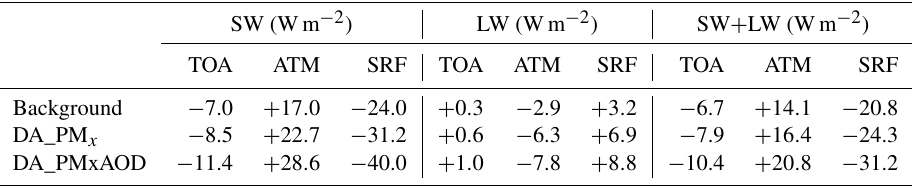
Table 5. The mean instantaneous clear-sky shortwave (SW), longwave (LW), and the net (SW + LW) direct radiative forcing (Wm − 2 ) at the top of the atmosphere (TOA), in the atmosphere (ATM) and at the surface (SRF) in the background and the simulations restarted from the analyses of DA_PM x and DA_PM x _AOD at 1h after the analysis times of AOD at Kashi in April 2019. SW (Wm − 2 ) LW (Wm − 2 ) SW + LW (Wm − 2 ) TOA ATM SRF TOA ATM SRF TOA ATM SRF Background − 7.0 + 17 . 0 − 24.0 + 0 . 3 − 2.9 + 3 . 2 − 6.7 + 14 . 1 − 20.8 DA_PM x − 8.5 + 22 . 7 − 31.2 + 0 . 6 − 6.3 + 6 . 9 − 7.9 + 16 . 4 − 24.3 DA_PMxAOD − 11.4 + 28 . 6 − 40.0 + 1 . 0 − 7.8 + 8 . 8 − 10.4 + 20 . 8 −